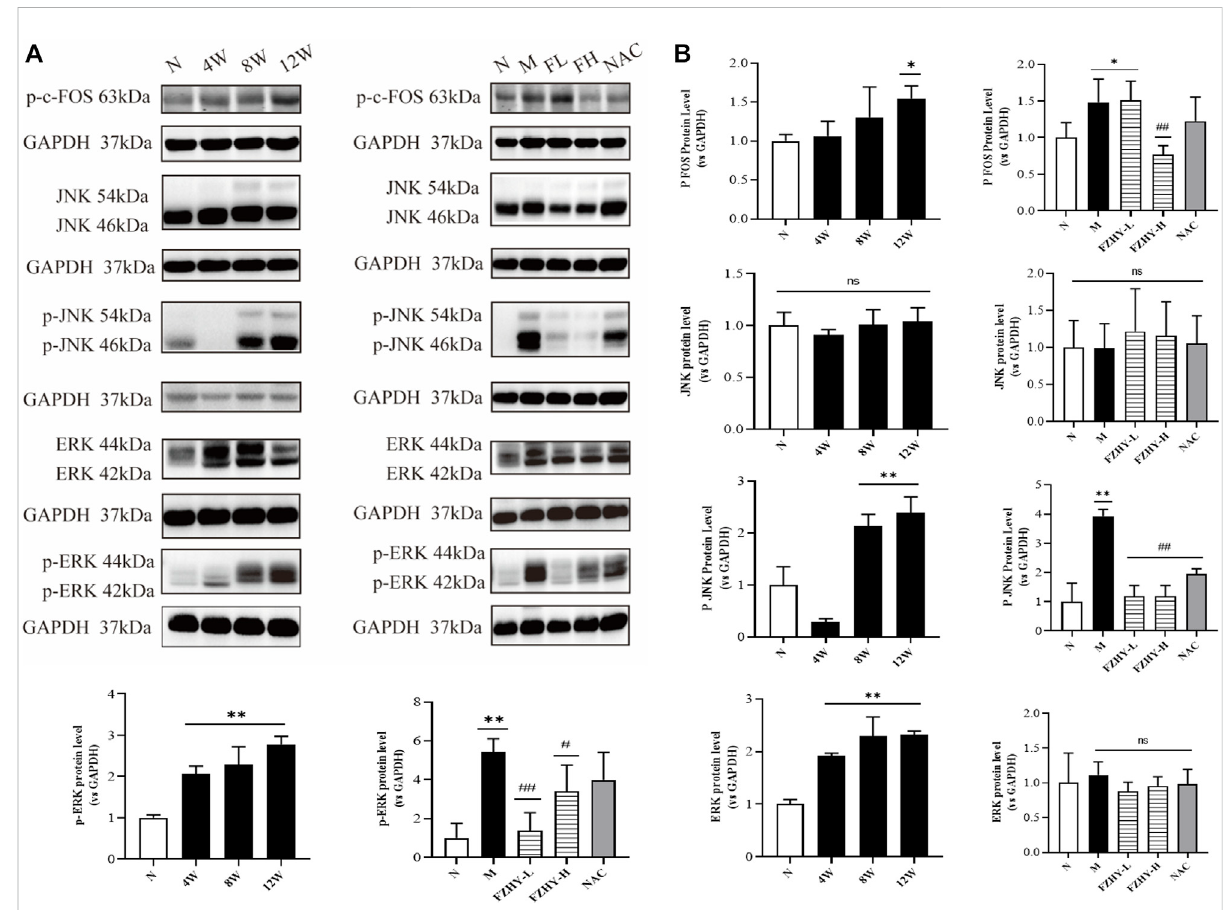
FIGURE 6 Western blot analyses further illustrate the mechanisms of FZHY against renal fi brosis. Dynamic experimental model mice were intraperitoneal injected with Aristolochic Acid I (AAI) (4 mg/kg body weight) twice a week and sacri fi ced at 4 weeks, 8 weeks, and 12 weeks. Pharmacodynamic experimental model mice were intraperitoneal injected with AAI (4 mg/kg body weight) twice a week for 12 weeks. From the fourth week of AAI injection, mice were intragastrically administered FZHY (1.44 g/kg, 2.88 g/kg body weight) or NAC (3.0 g/kg body weight) per day for 8 weeks. Allmice weresacri fi ced.p-c-fos,JNK,p-JNK, ERK,and p-ERKexpressioninmicerenal tissueswereanalyzed usingWestern blotanalysis (A) .p-JNK, ERK, andp-ERK signi fi cantly increasedatboth 8 weeks and12 weeks after AAI administration (B) . After theFZHY gavage,proteinexpression levels of JNK and ERK did not change signi fi cantly, but expression levels of p-JNK and p-ERK signi fi cantly decreased compared with model group (B) . * p < 0.05, compared with normal group; ** p < 0.01, compared with normal group; # p < 0.05, compared with model group; ## p < 0.01, compared with model group; ns, no signi fi cance, compared with model